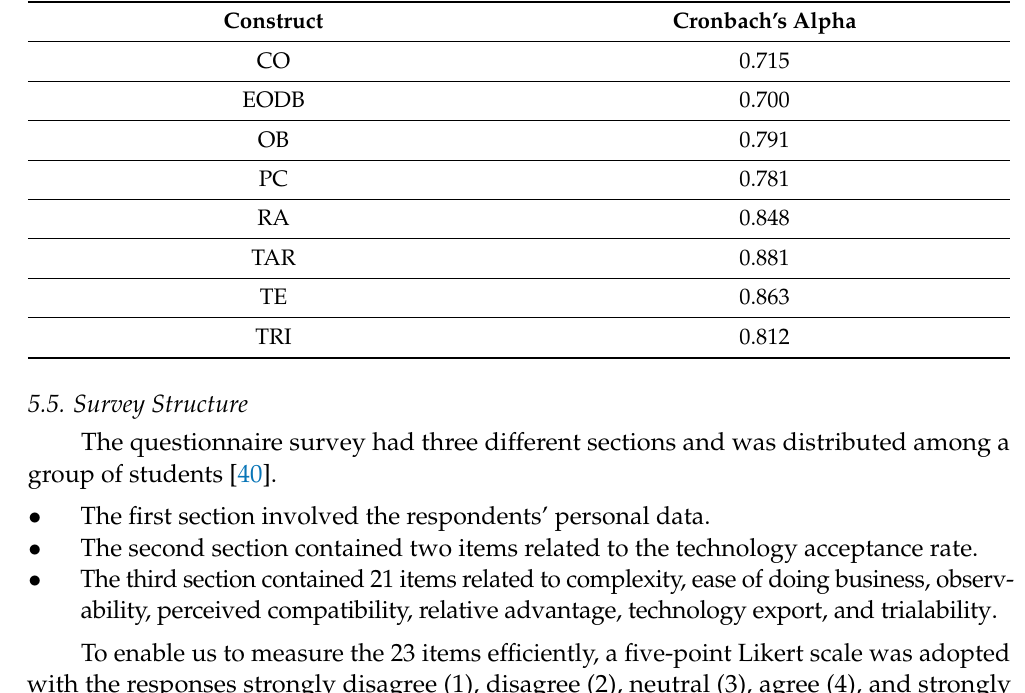
Table 4. Cronbach’s alpha values for the pilot study (Cronbach’s alpha ≥